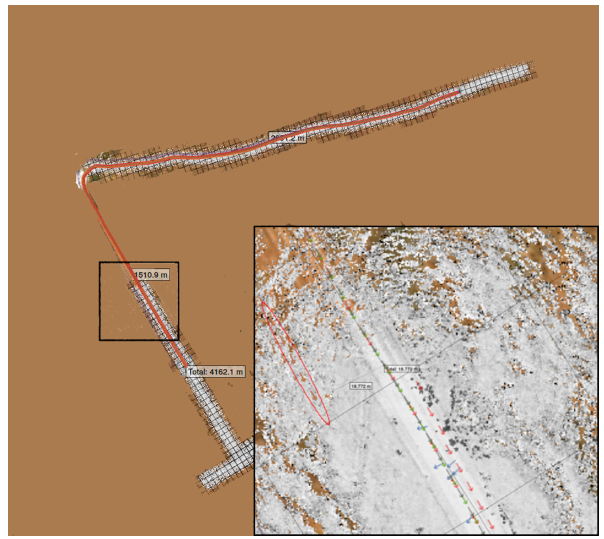
Figure 9. Costmap-Based Localization (CBL) on a static Persistent Map (part a). The (two part) persistent map, overlaid with four Kalman-filter based state estimates: GPS in green, GPS + CBL